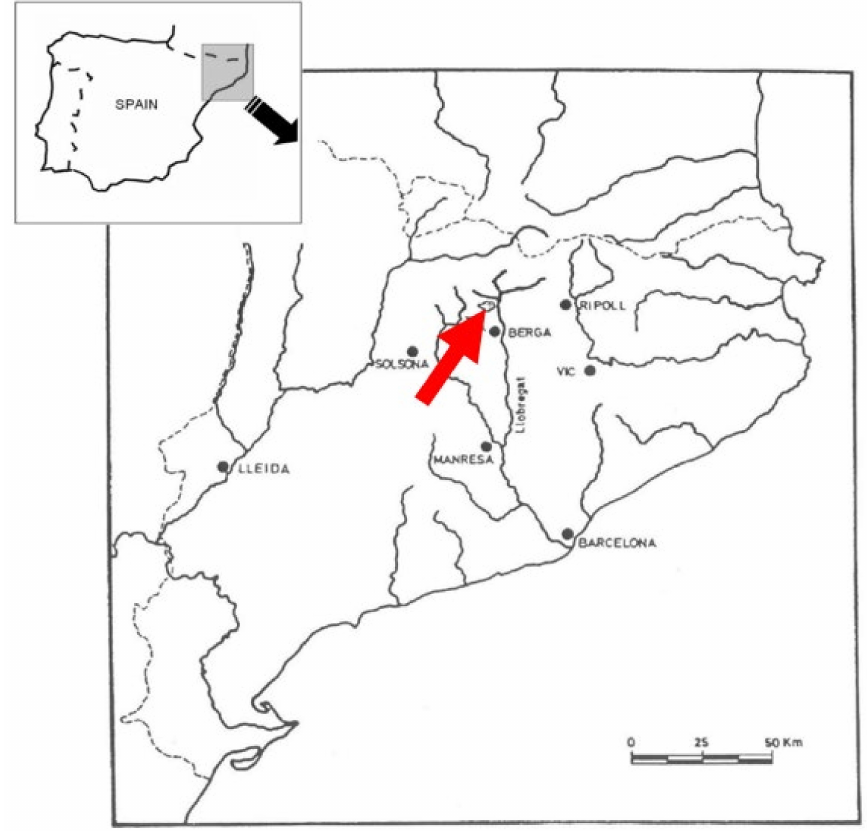
Figure 1. Location of Vallcebre valley (red arrow) within the Pyrenees range, NE of Spain.